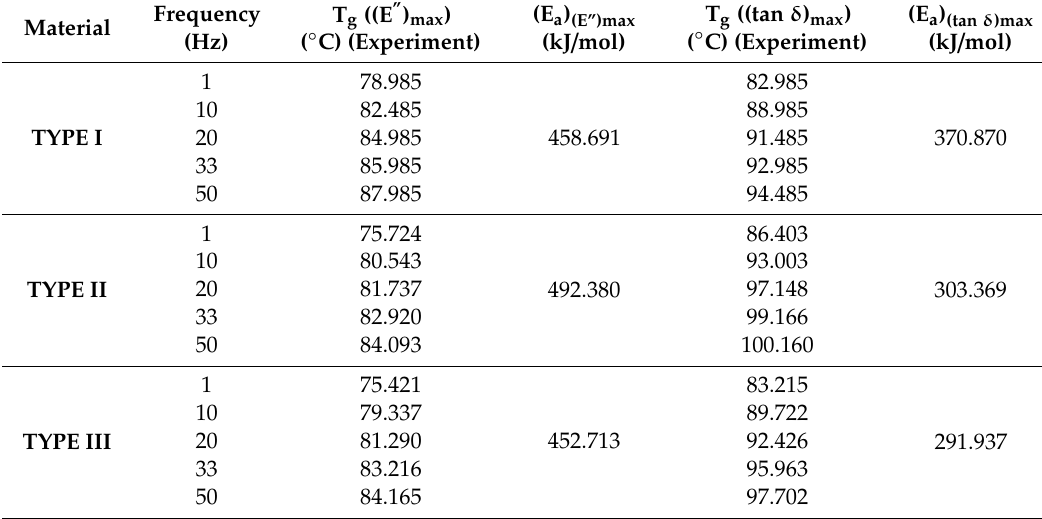
Table 4. Activation energy of carbon / epoxy